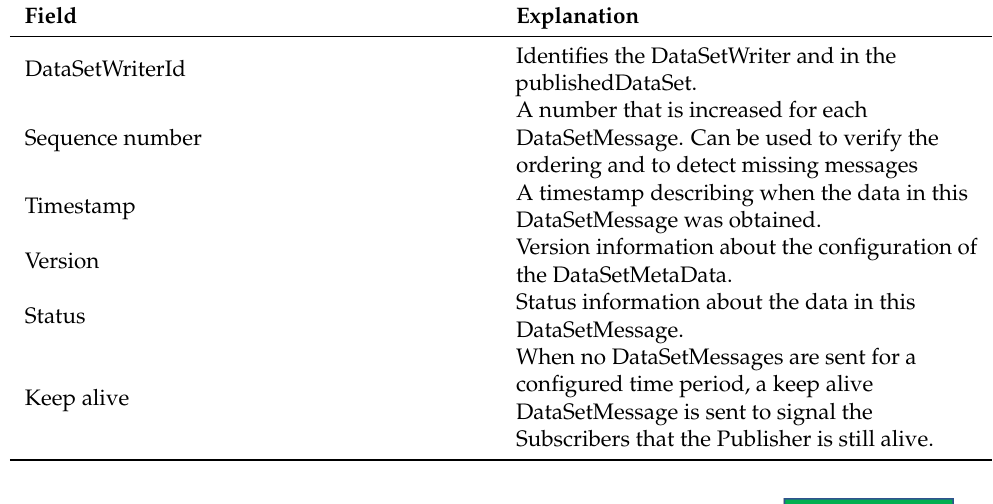
Table 1. Data Fields in DataSetMessage.